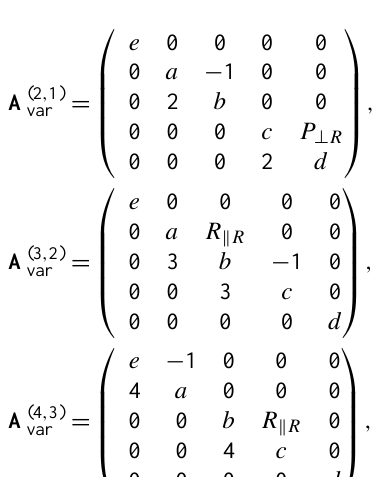
the corresponding joint variation